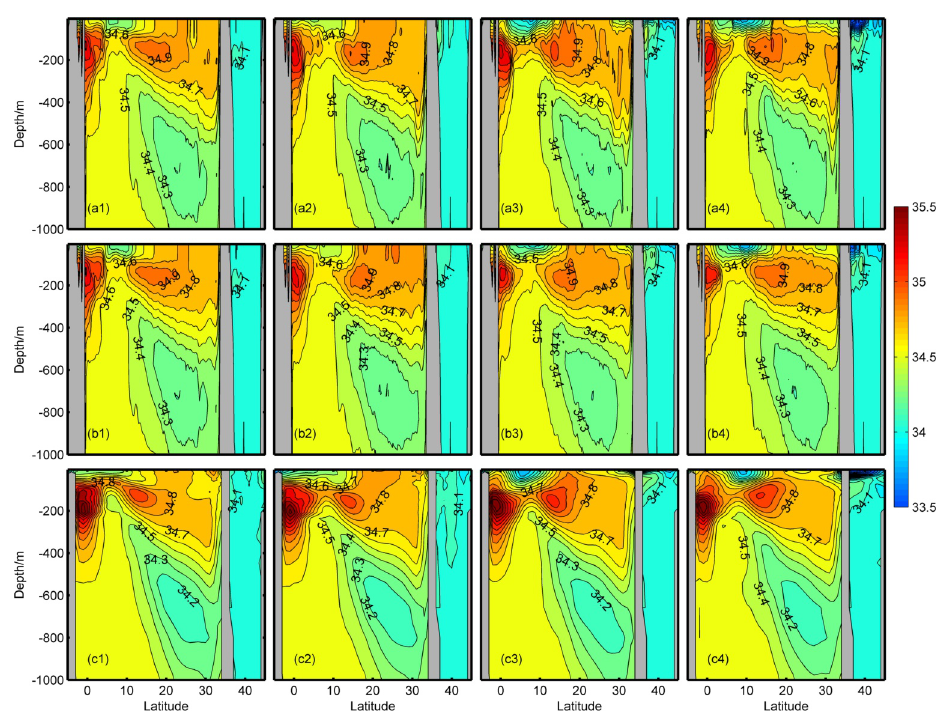
Figure 12. Distribution of salinity (in psu) at transect of 137 ◦ E: (a) AF, (b) SF and (c) EN4.0.2 for (1) January, (2) April, (3) July and (4)